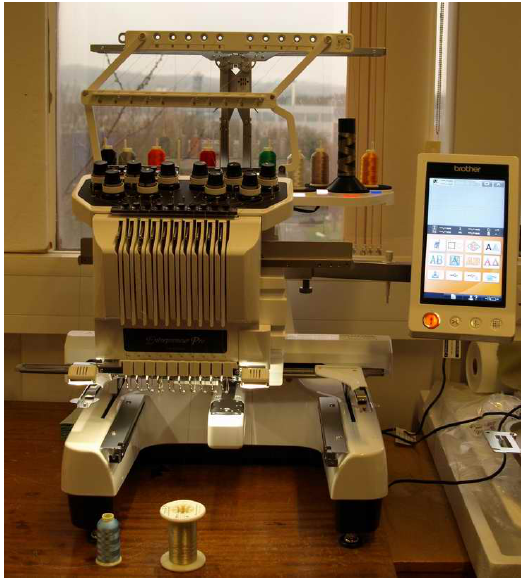
Figure 5. Computer aided embroidery machine at Loughborough